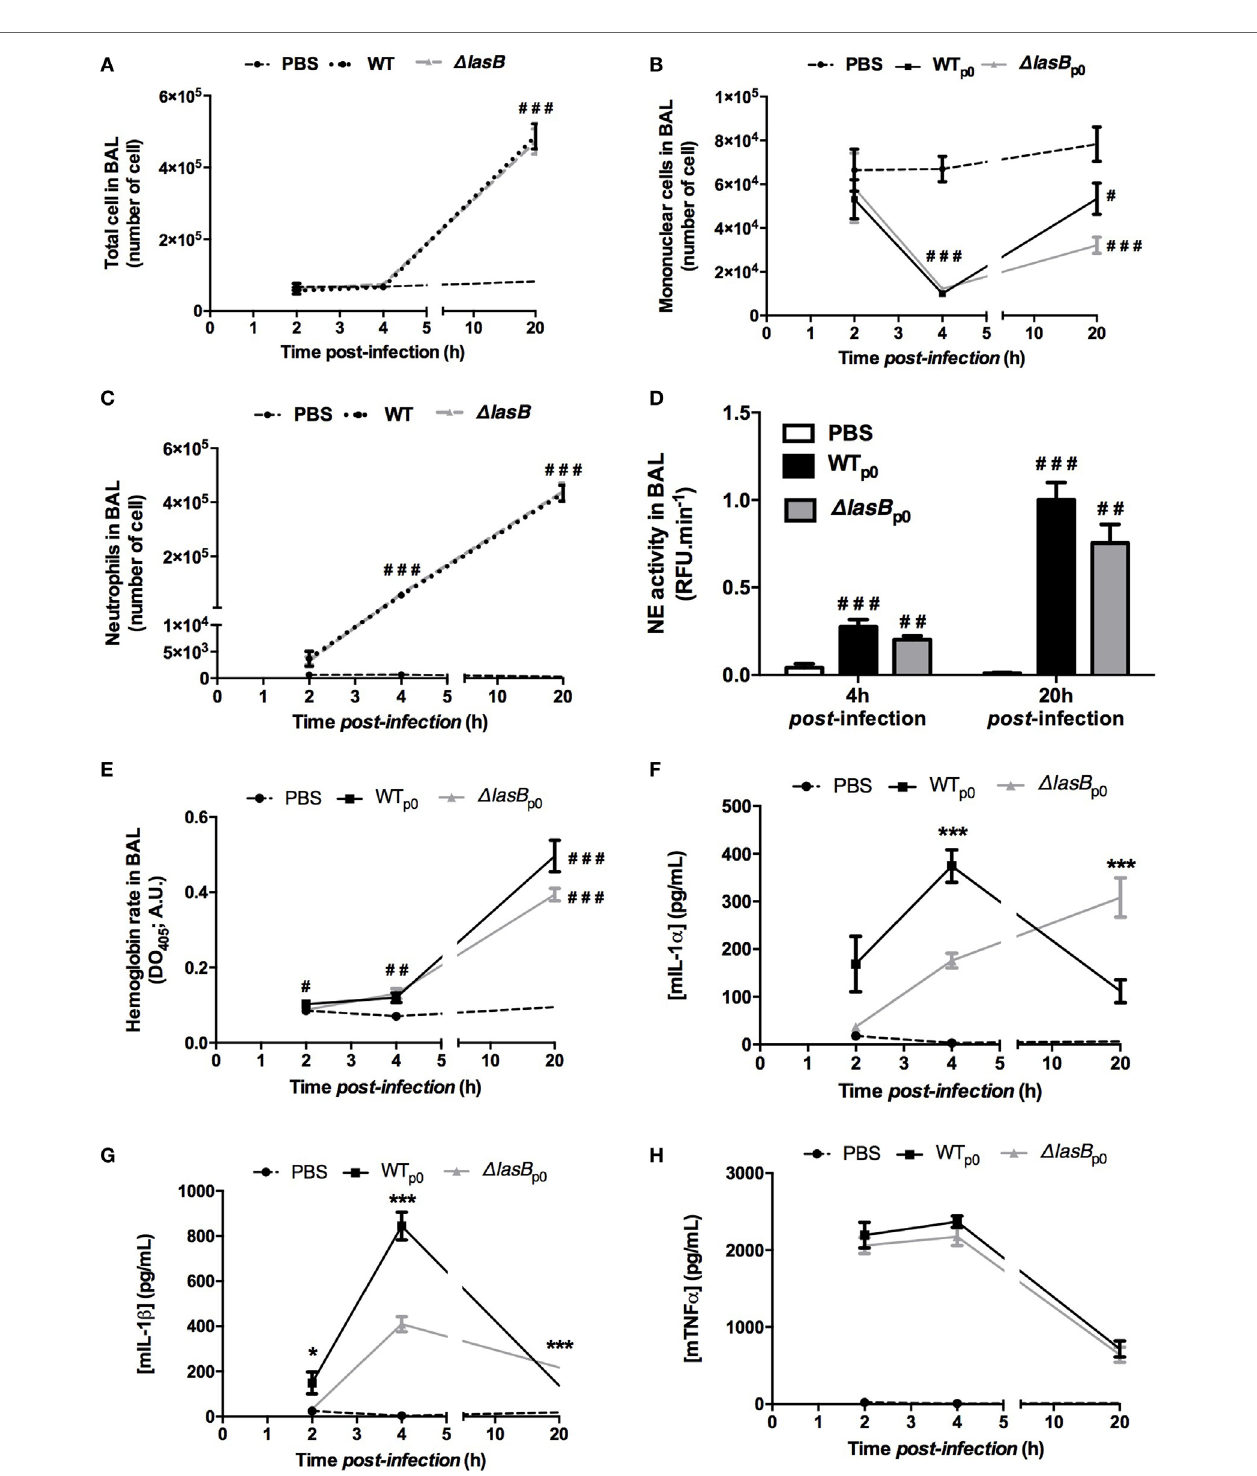
FigUre 3 | Analysis of inflammatory markers following in vivo Pseudomonas aeruginosa infection of C57/Bl6 mice. (a) BAL fluid (BALF) samples collected from the experiments depicted in Figure 2 were analyzed, at various time points, for total cell numbers, macrophage/mononuclear and neutrophil numbers (a–c) . Also, neutrophil elastase (NE) activity, as an index of neutrophil activation, was measured, using a specific fluorogenic substrate (D) . Hemoglobin release, as an index of tissue injury (OD at 413 nm), was also measured (e) . Additionally, BALF IL-1- α , IL-1 β , and TNF- α levels were measured by enzyme-linked immunosorbent assays [ (F–h) , respectively]. For all experiments, results are presented as mean ± SEM and ANOVA, followed by Bonferonni tests analysis: Statistical significance: (a) ### p < 0.001 compared to PBS; (B) # , ## , ### : p < 0.05, < 001, < 0.001, respectively, compared to PBS; (c) ### p << 0.001, compared to PBS; (D) ## , ### : p < 001 and < 0.001, respectively, compared to PBS; (e) # , ## , ### : p < 0.05, < 001, < 0.001, respectively, compared to PBS; (F,h) * p < 0.05, *** p < 0.001 compared to